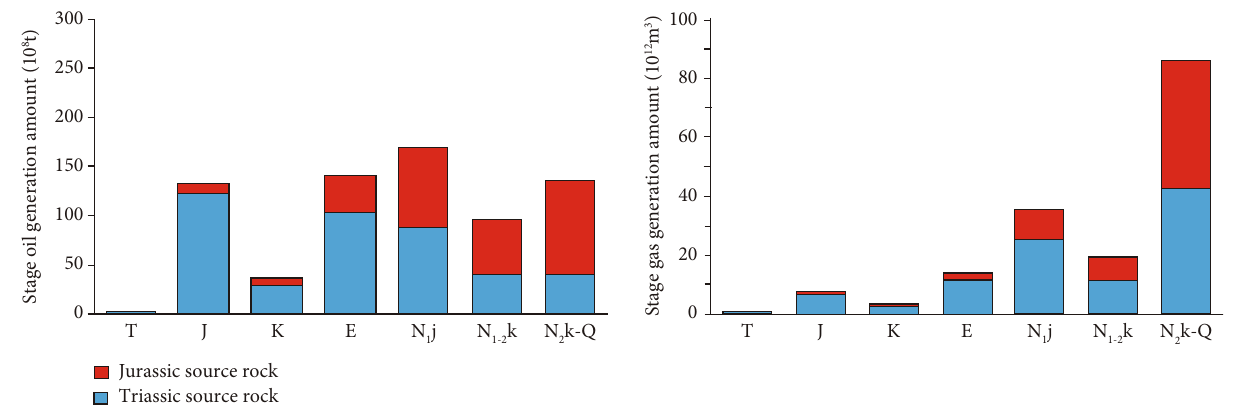
Figure 12: Hydrocarbon generation history of the J-T source rock in the Kuqa foreland basin.